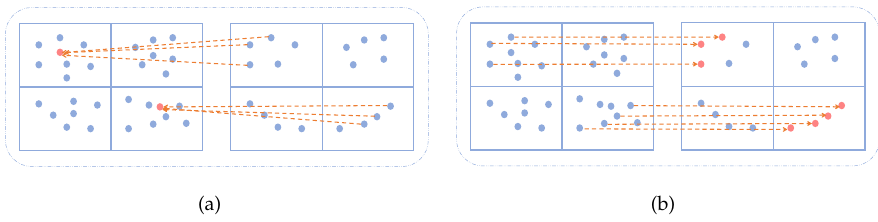
Figure 2. Feature fusion process: ( a ) feature interpolation based on distance and ( b ) direct